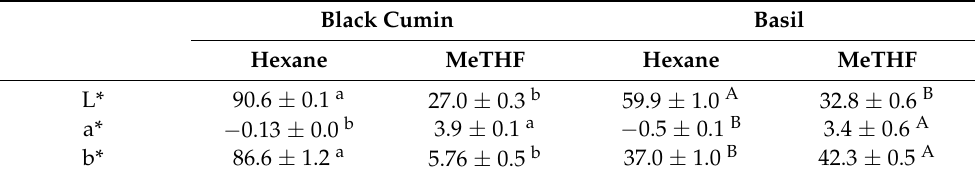
Table 1. Color parameters (CIELAB) of black cumin and basil seeds oils obtained with conventional and green